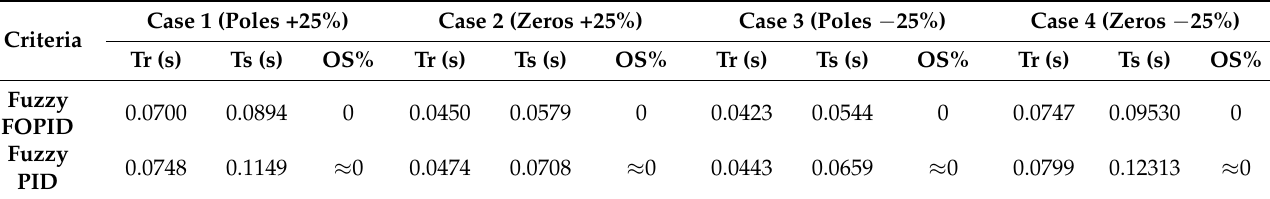
Figure 24. Dynamic response of the system with the fuzzy FOPID and fuzzy PID controllers under parametric uncertainties, case 4. Table 7. Comparison between the fuzzy FOPID and other controllers’